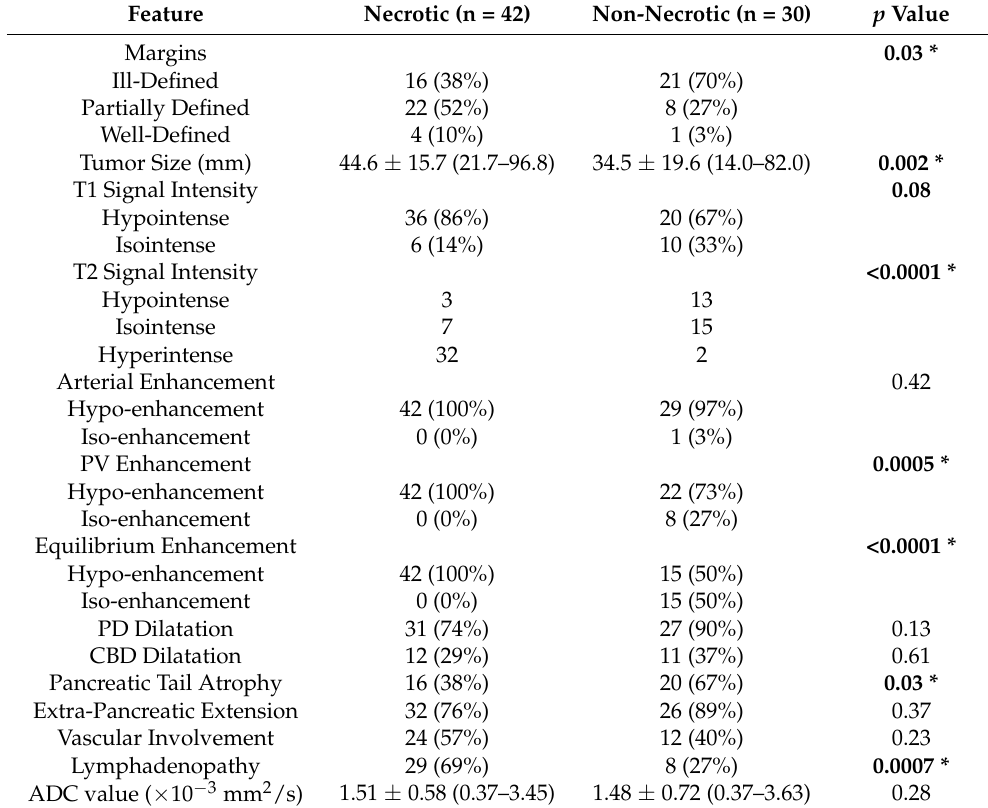
Table 2. Comparison of MRI findings between necrotic and non-necrotic